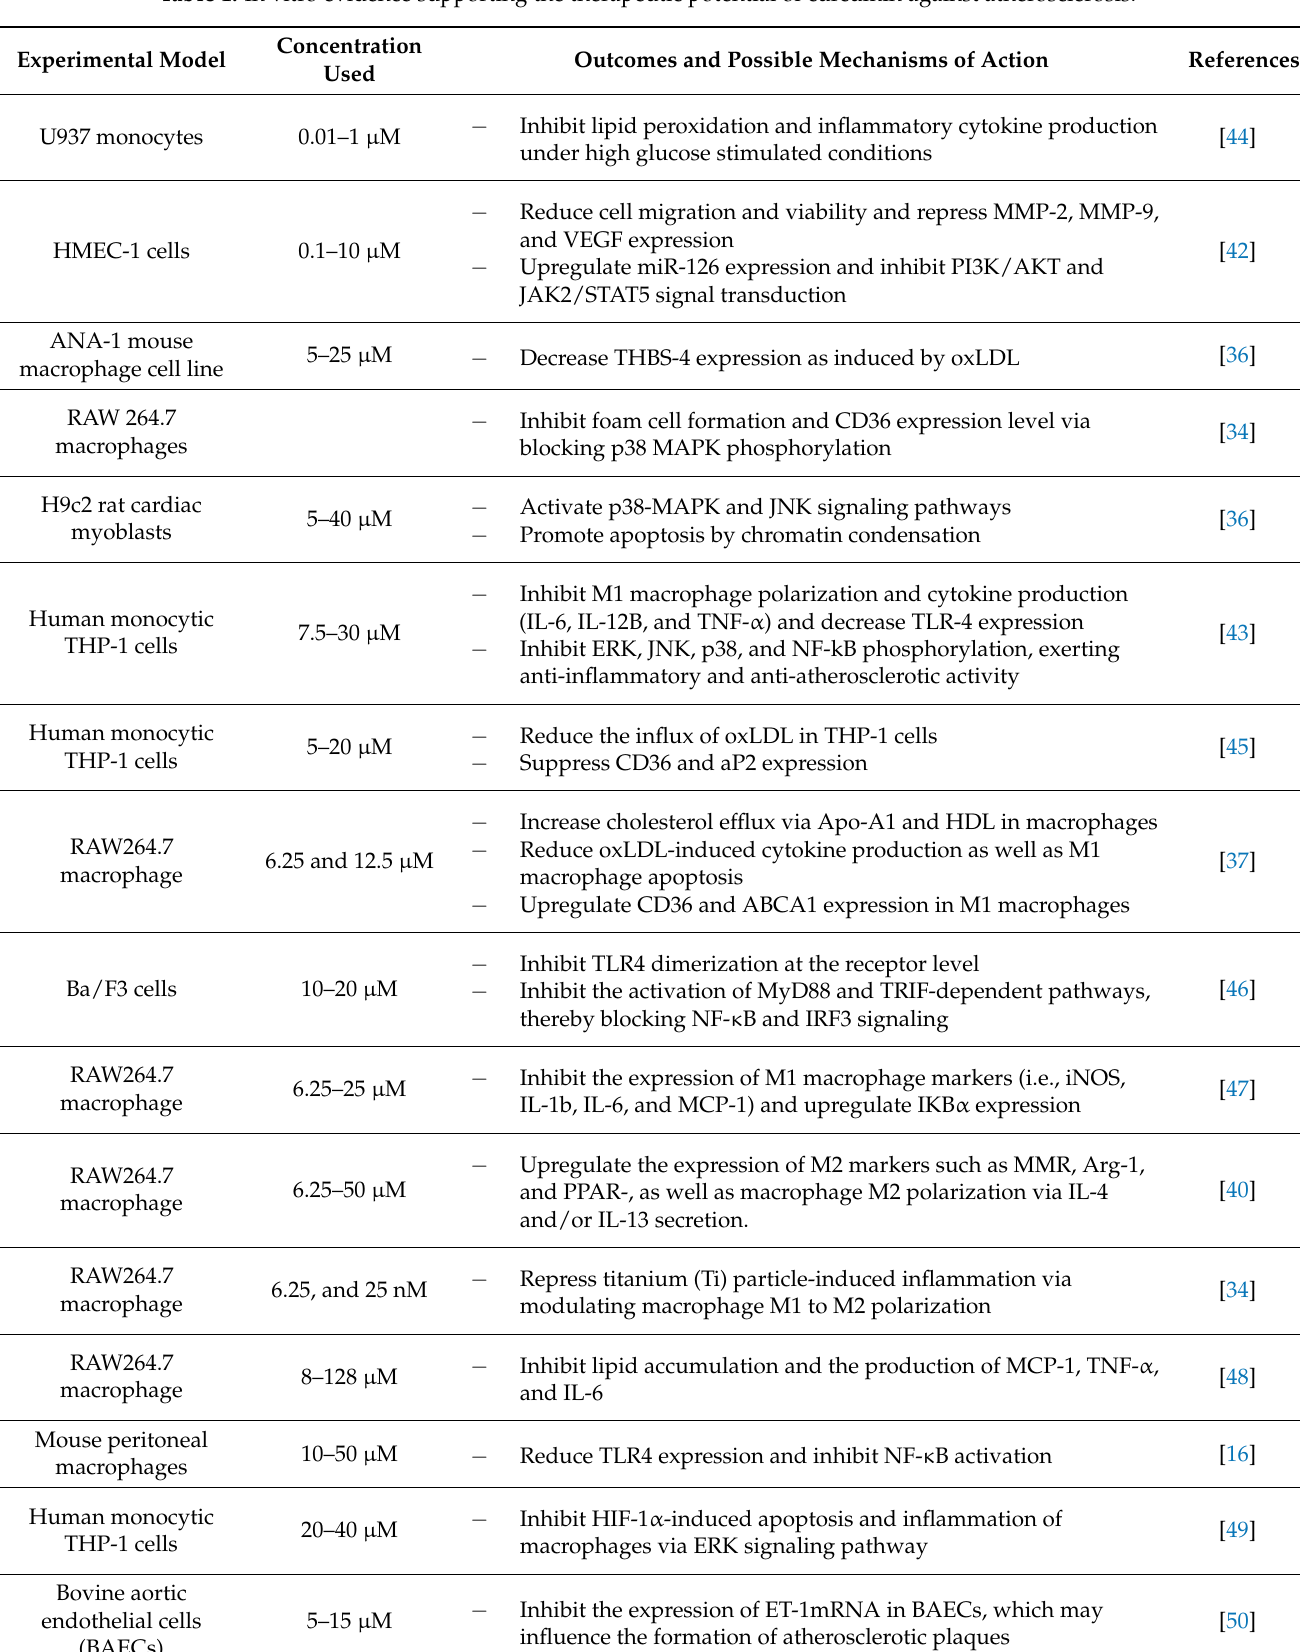
Table 1. In vitro evidence supporting the therapeutic potential of curcumin against atherosclerosis. Concentration Outcomes and Possible Mechanisms of Experimental Model